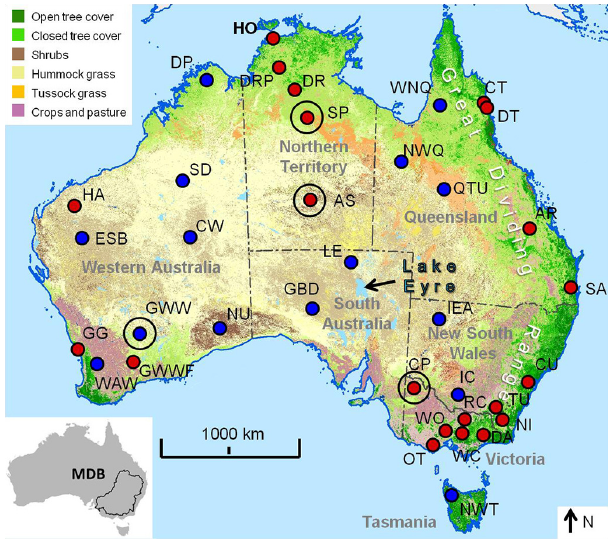
Figure 1. Land cover map of Australia showing closed and open tree cover in dark and light green, respectively. The purple colors that occur predominantly in the southwest and southeast represent crops and pasture. Brown marks shrubs, orange colors mark tus- sock grass and light brown colors mark hummock grass cover across most of the semi-arid and arid interior (land cover classes were ag- gregated based on Lymburner et al., 2011). The most prominent to- pographic feature is the Great Dividing Range that runs along the eastern seaboard. Locations of the 21 OzFlux flux tower sites and 15 additional sites are shown as red and blue circles. We used the EVI time series at the sites for phenological algorithm development and testing (site list provided in Table 1). The phenology for the sites marked by large black circles is presented and discussed in Sect. 2.2.3. The bottom-left panel shows the extent of the